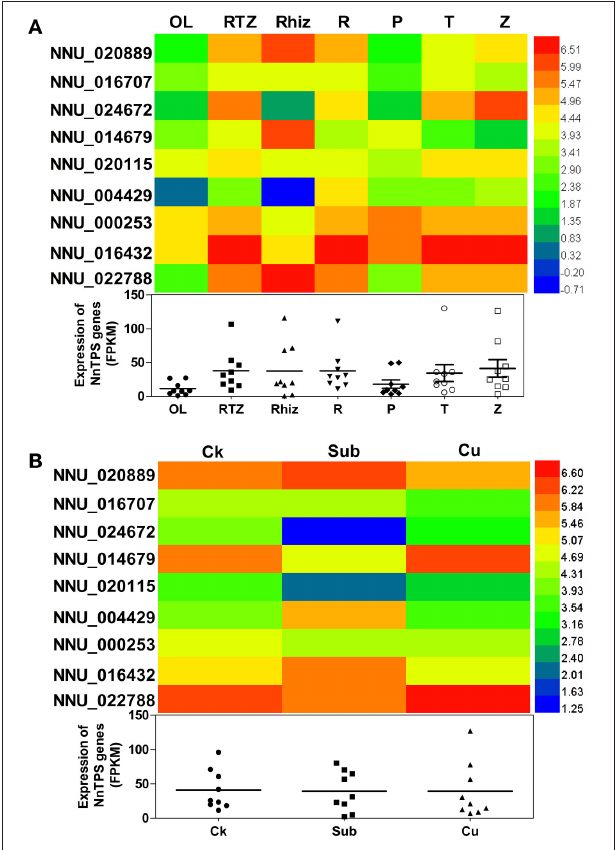
FIGURE 7 | Expression profiles of the nine NnTPS genes in different tissues (A) and upon submergence and copper stresses (B). The color scale represents RPKM normalized log 2 transformed data. Red indicates high expression level and blue indicate low expression level. OL, leaf; RTZ, Combined Rhiz Tip Zone; Rhiz, Rhizome internode; R, Root; P, Petiole; T, Rhizome apical tip; Z, Rhizome elongation zone.